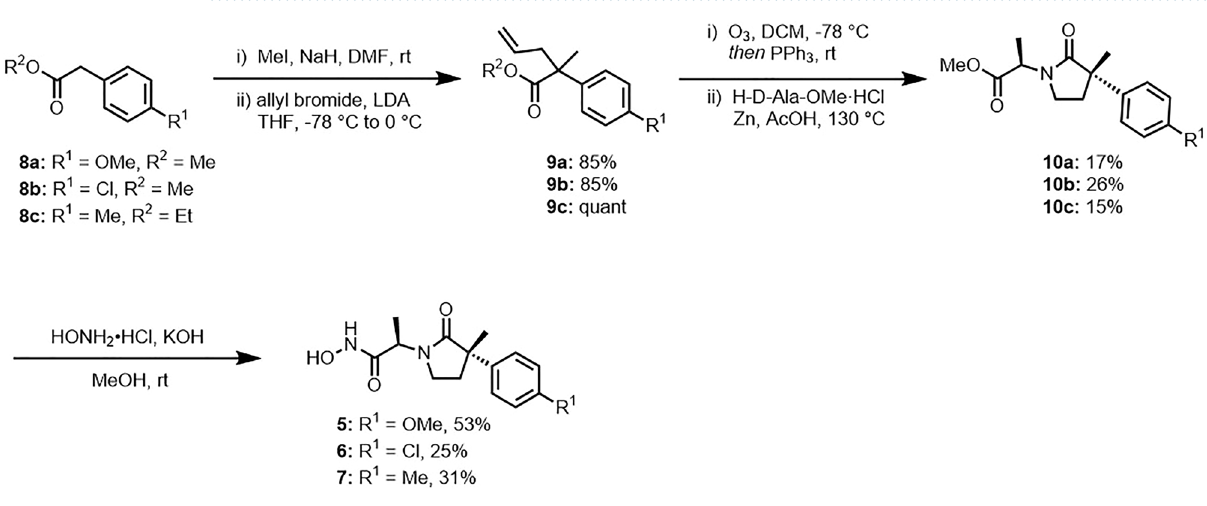
Figure 3. Synthesis of compounds 5 –